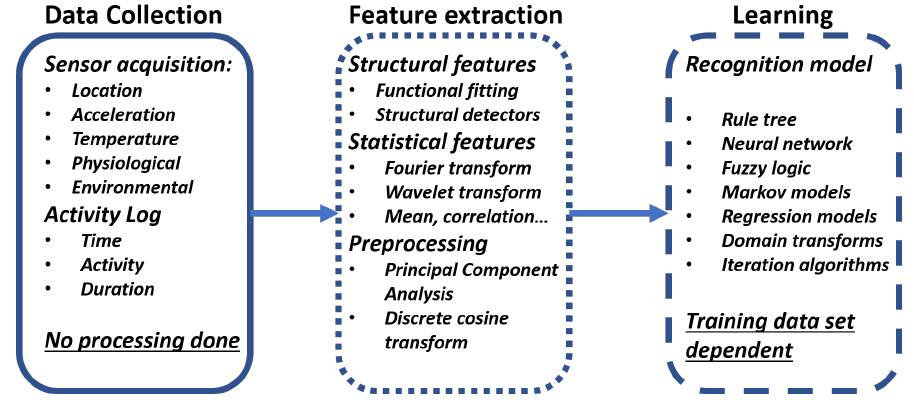
Figure 1. Learning process of an HAR